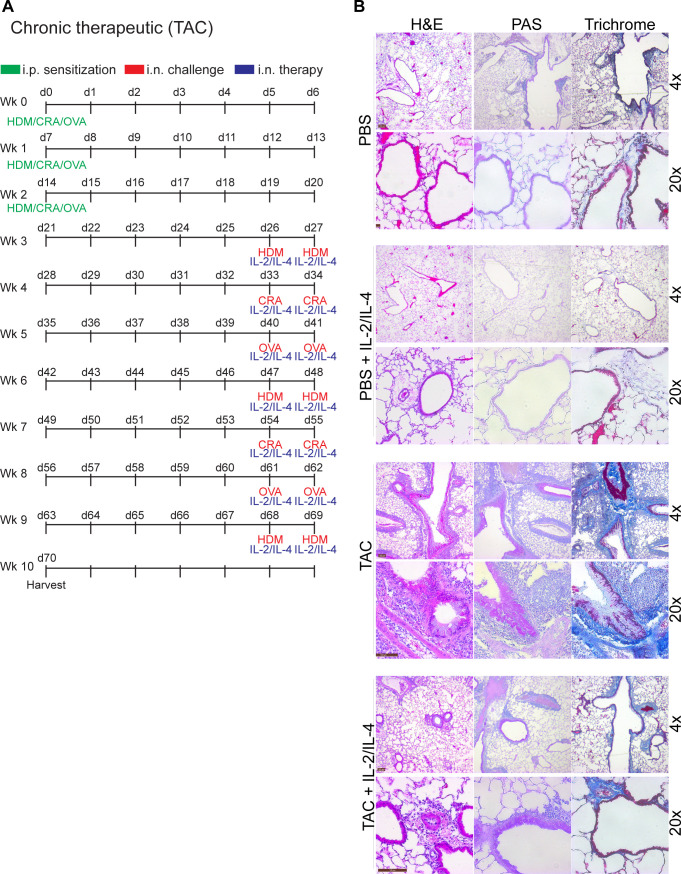
Administration of IL-2 and IL-4 therapeutically suppresses TAC-induced chronic asthma.(A) Challenge and treatment schedule for therapeutic TAC-induced chronic asthma trial in Figure 6H. Mice were sensitized to the triple antigens once weekly for the first 3 weeks. Afterwards, all challenges and treatments were delivered i.n. Mice received HDM, CRA, and OVA in a rotating weekly schedule, and also received IL-2 and IL-4 in combination following the challenge. (B) Pulmonary disease severity was analyzed by FFPE tissues that underwent H and E, PAS, Trichrome staining and imaged at 4× and 20×. N ≤ 5. Representative H and E histology for Figure 6H.